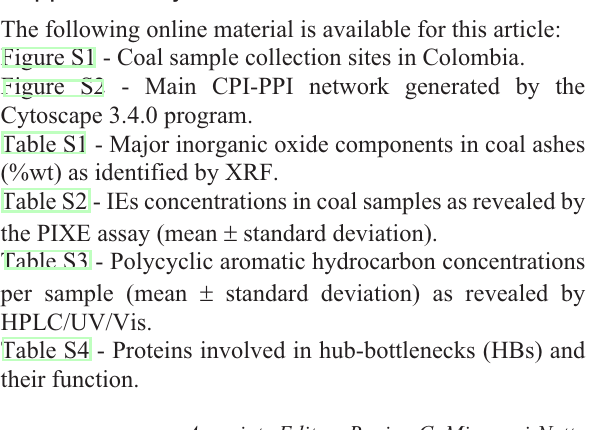
Table S4 - Proteins involved in hub-bottlenecks (HBs)